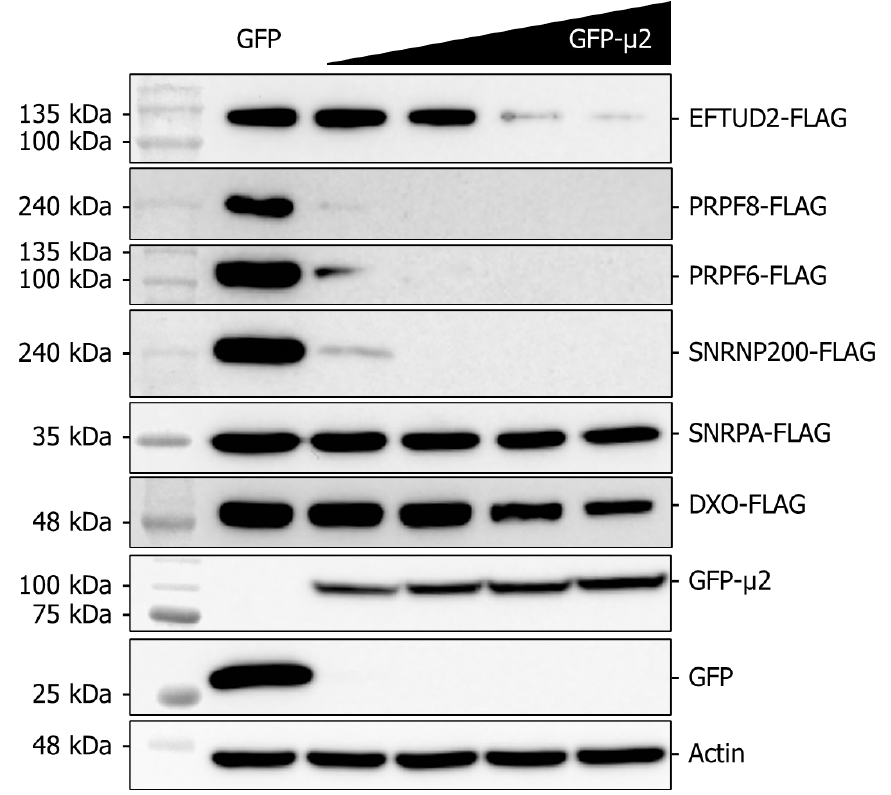
Figure 5. The presence of µ 2 hampers the ectopic expression of U5 proteins in a dose-dependent manner. Co-expression of EFTUD2, PRPF8, PRPF6, and SNRNP200 FLAG-tagged constructions with increasing doses of GFP- µ 2 for 48 h in HEK 293T cells. SNRPA (U1 snRNP) and DXO (RNA metabolism) were used as